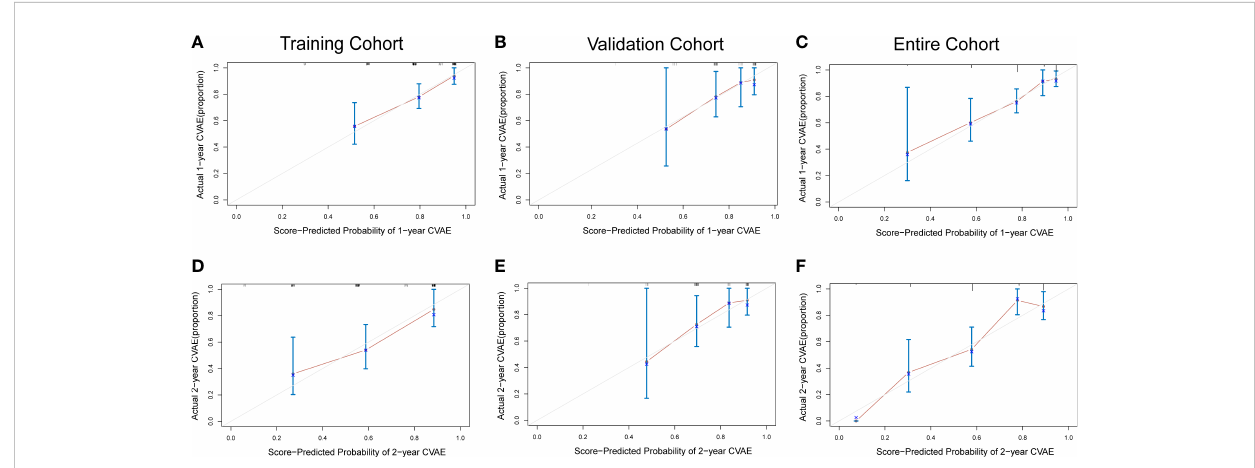
FIGURE 2 Calibration curves for predicting 1- and 2-year CVAE-free survival in the (A, D) training cohort, (B, E) validation cohort, and (C, F) entire